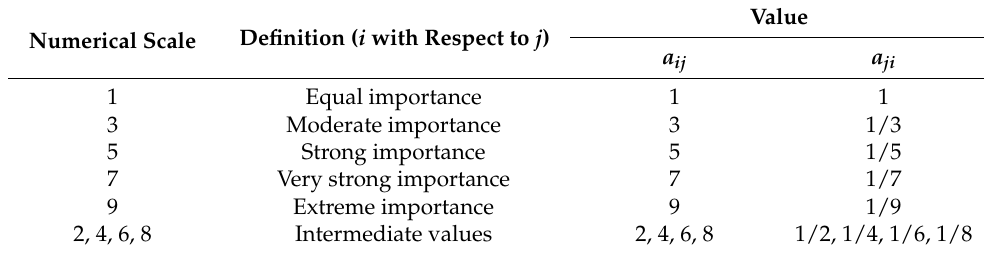
Table 2. Rating scale of AHP